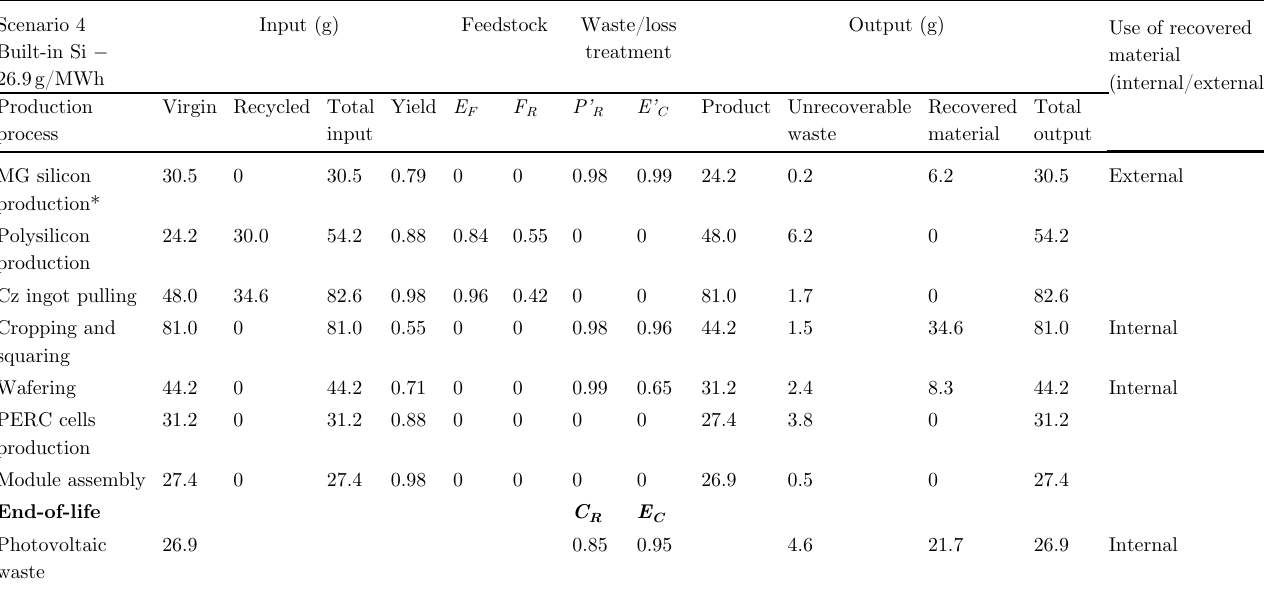
Table A4. Material fl ows for 2032 ITRPV projection/Closed-loop scenario.